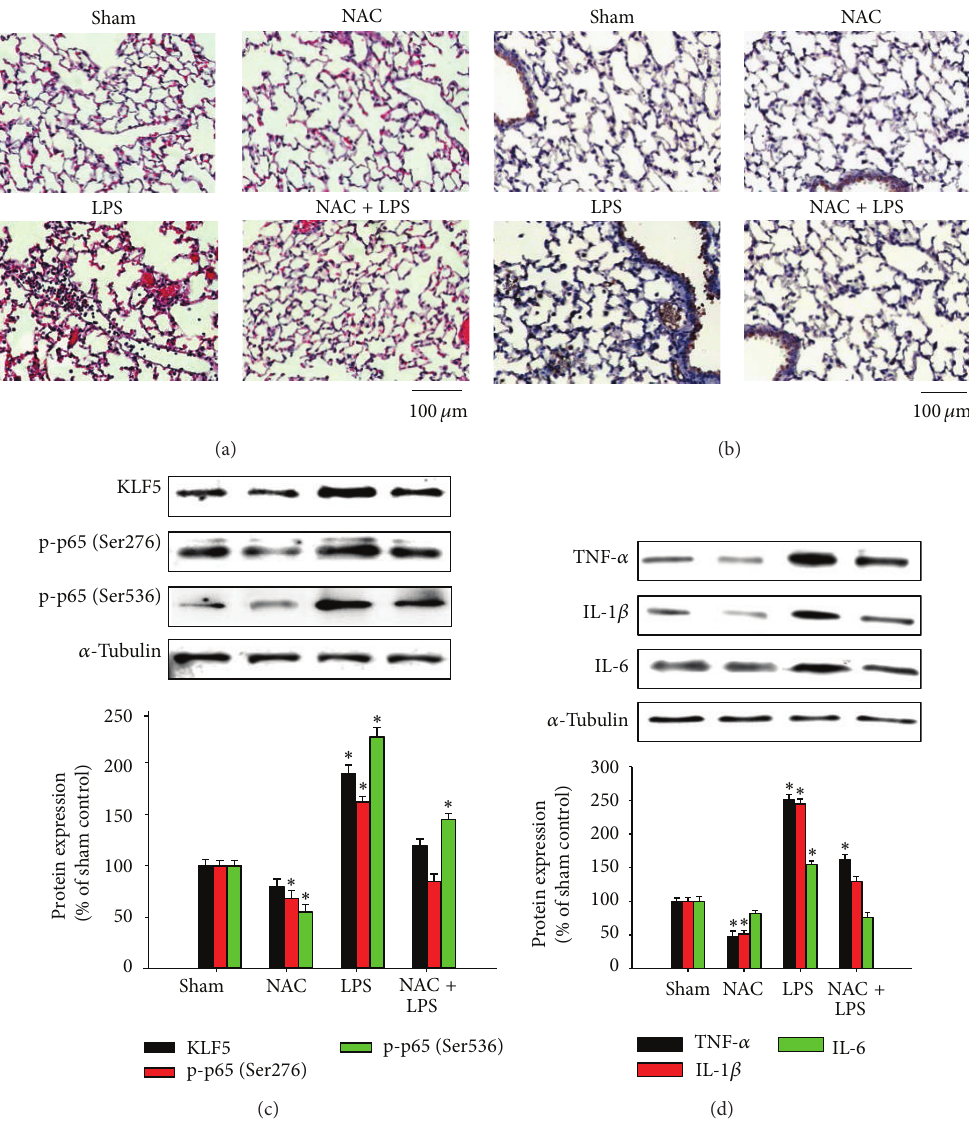
Figure 6: Kr¨uppel-like factor 5, nuclear factor-kappaB subunit, and proinflammatory cytokine expression in lipopolysaccharide- (LPS-) induced acute lung inflammation in mice. BALB/C mice were intraperitoneally injected with or without N-acetylcysteine (NAC; 150 mg/kg) for 1h before intraperitoneal administration of LPS (20 mg/kg) for 8 h. Lung tissue sections were (a) stained with hematoxylin and eosin to observe the infiltration of cells and (b) analyzed immunohistochemically to evaluate KLF5 expression. A representative stained lung tissue from 3 independent experiments is shown. (c) KLF5, p65, phospho-p65 (Ser276), and phospho-p65 (Ser536) protein expression and (d) tumor necrosis factor- 𝛼 (TNF- 𝛼 ), interleukin- (IL-) 1 𝛽 , and IL-6 expression were evaluated using western blotting. We observed histological changes including inflammatory cell infiltration, focal areas of fibrosis with collapsed air alveoli, and thickening of the alveolar wall (a) as well as upregulated KLF5 (b), p65, phospho-p65 (Ser276), and phospho-p65 (Ser536) protein expression (c) and upregulated TNF- 𝛼 , IL-1 𝛽 , and IL-6 expression